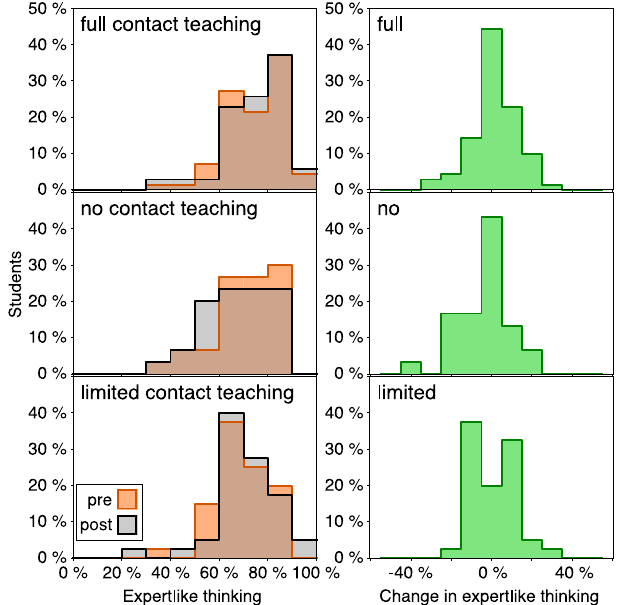
FIG. 3. Distribution of overall favorable CLASS scores in pre- and postsurveys, and the change in this